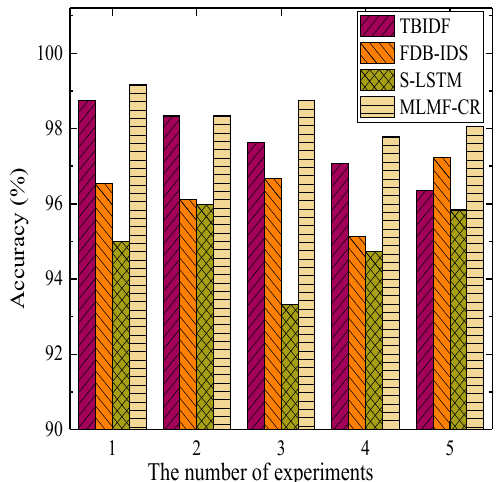
Figure 10. Fault diagnosis accuracy for different methods.